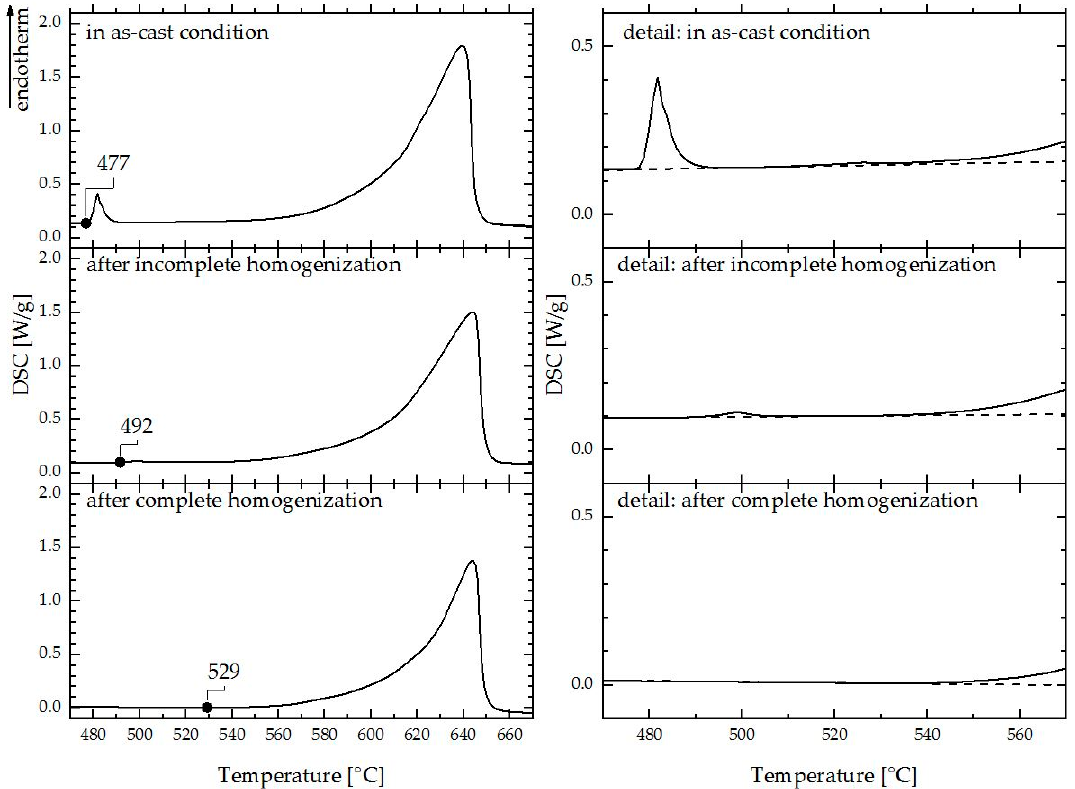
Figure 4. Change in DSC signal of experimental alloy #38 alloy during heating of three samples in conditions as-cast, incomplete homogenization and complete homogenization at constant heating rate of 10 K/min.